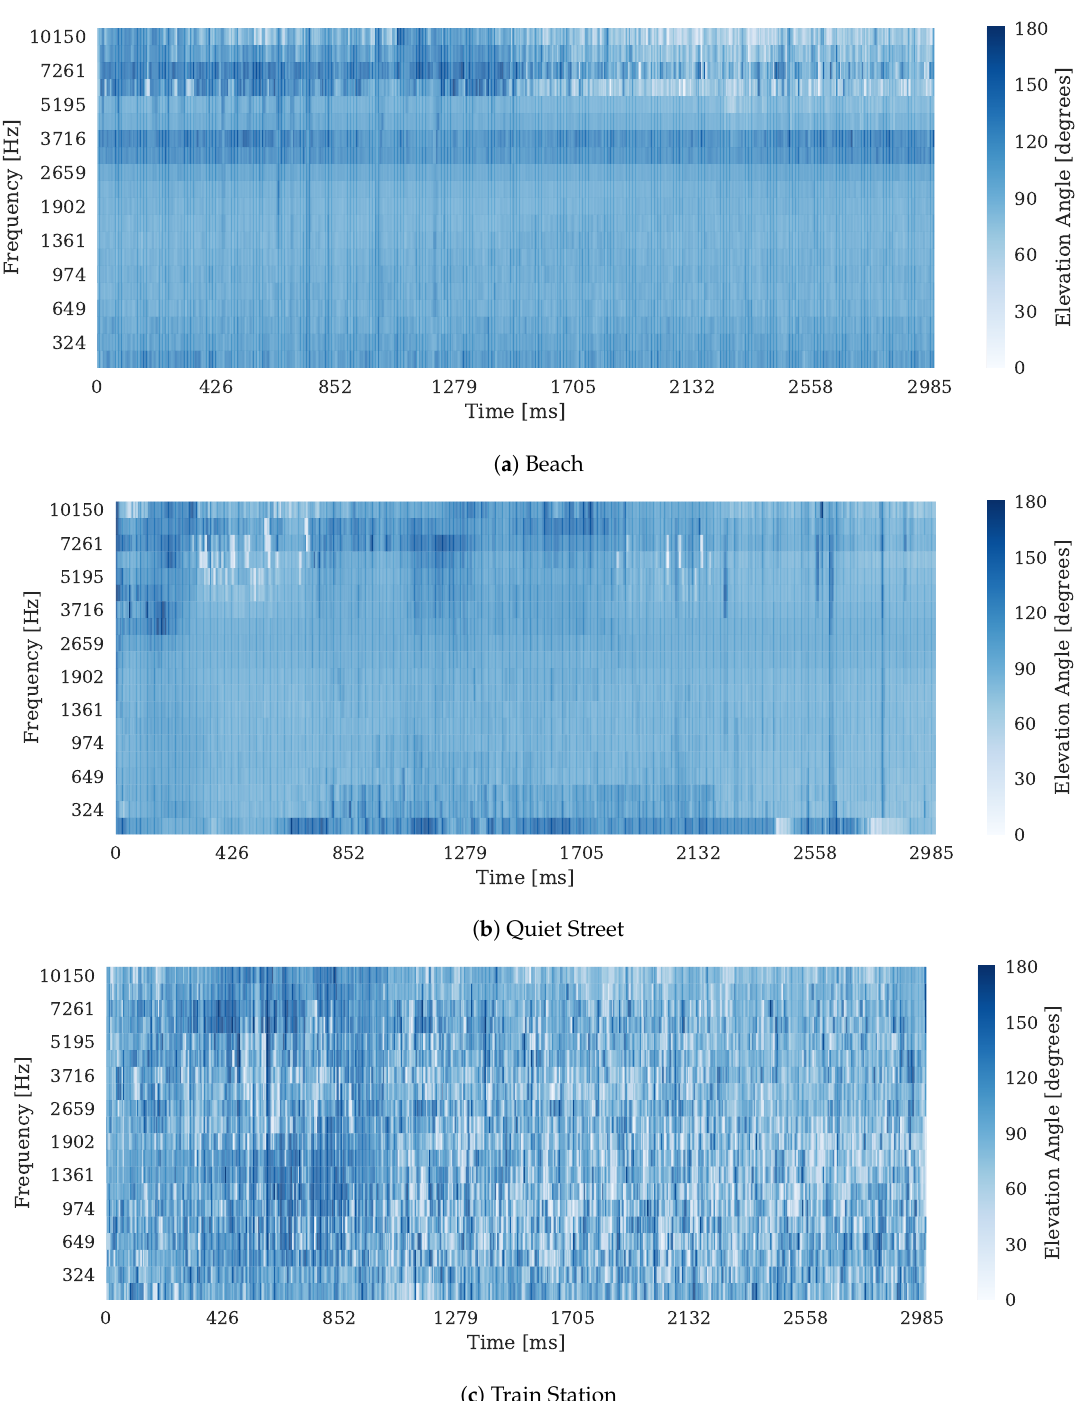
Figure 5. Heat maps depicting elevation estimates extracted from 30-s segments of Beach, Quiet Street and Train Station